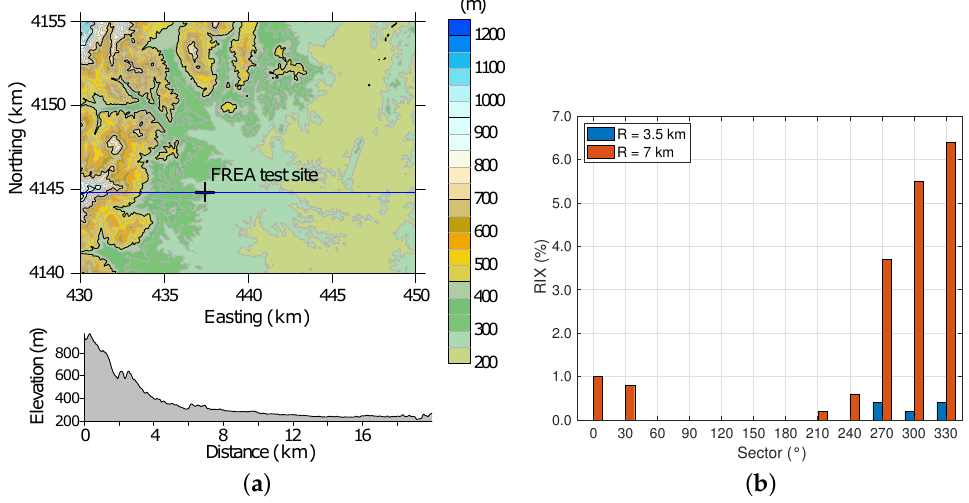
Figure 2. ( a ) Terrain complexity of the region around the test site; ( b ) Ruggedness index of the